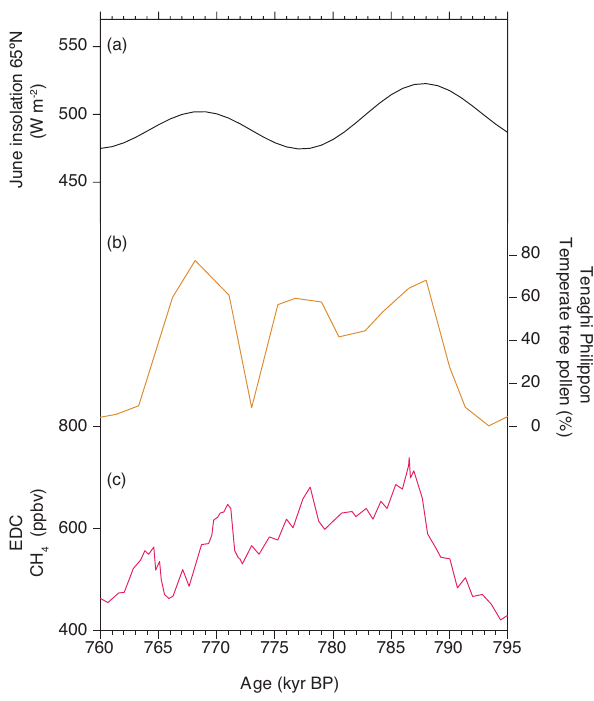
Fig. 8. Comparison of vegetation changes at Tenaghi Philippon, NE Greece with palaeoclimatic records of MIS 19. (a) 21 June insolation 65 ◦ N (Berger and Loutre, 1991); (b) temperate tree (Eu- rosiberian and mediterranean taxa) pollen percentages at Tenaghi Philippon, plotted on its own timescale (Tzedakis et al., 2006); (c) atmospheric CH 4 concentration from the EDC ice core (Louler- gue et al., 2008), plotted on the EDC3